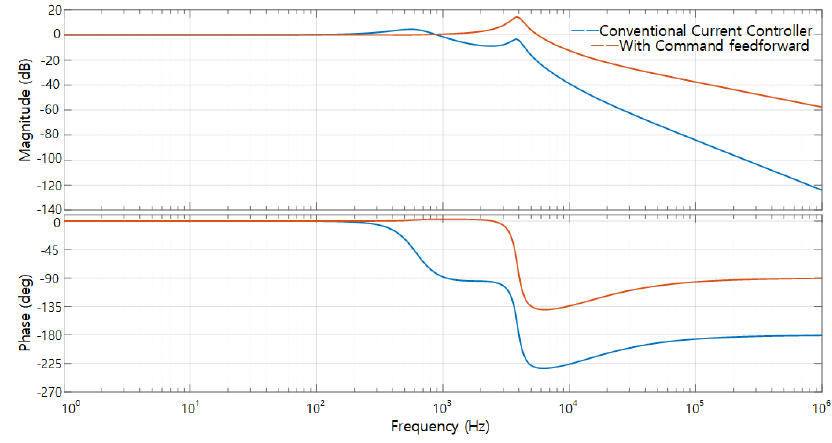
Figure 3. Bode plots of the conventional and proposed GCI current control systems.